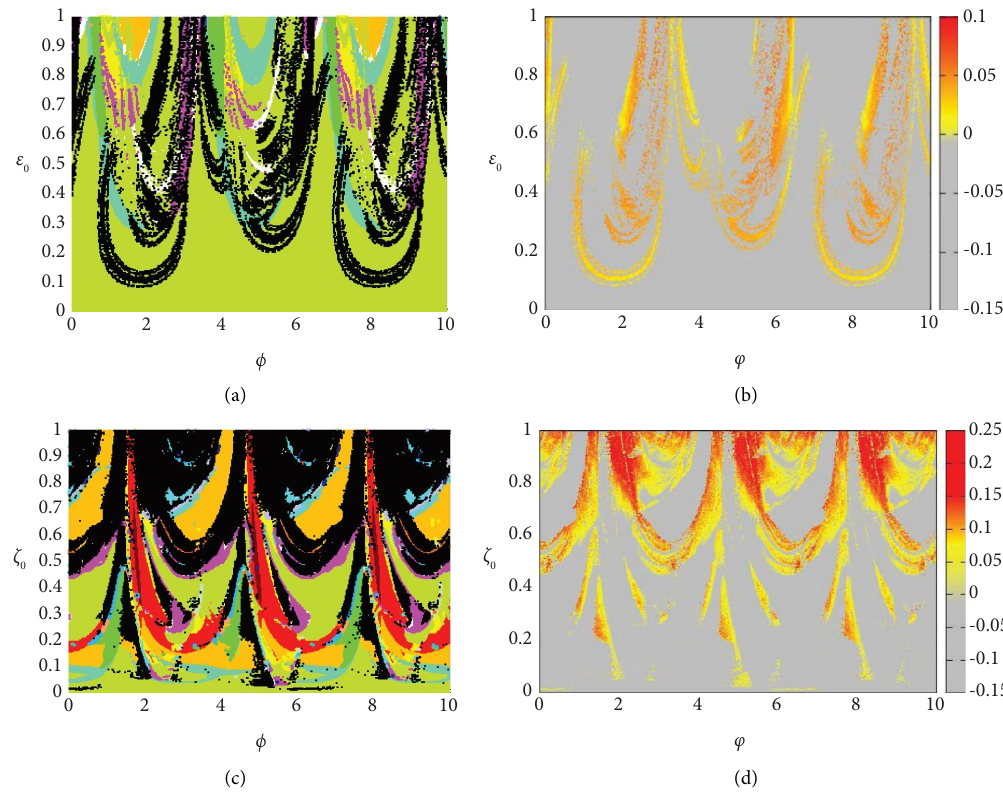
Figure 17: Phase-control strategy predicted by equation (3) for parameters F � 27 , ω � 1 . 44, and φ � 2 π t / T , φ ) and ( ξ , φ ) planes, respectively, for a control applied to the elastic term (a, b) and the dissipative term (c, d). Te left panel (Figures in ( ε 0 0 17 (a) and 17(c)) consists of the results before the phase control, while the right panel (Figures 17(b) and 17(d)) exhibits the corresponding results after applying the chaos phase control strategy. We can observe that only a correct choice of the phase makes it possible to ensure chaos control for all values of other